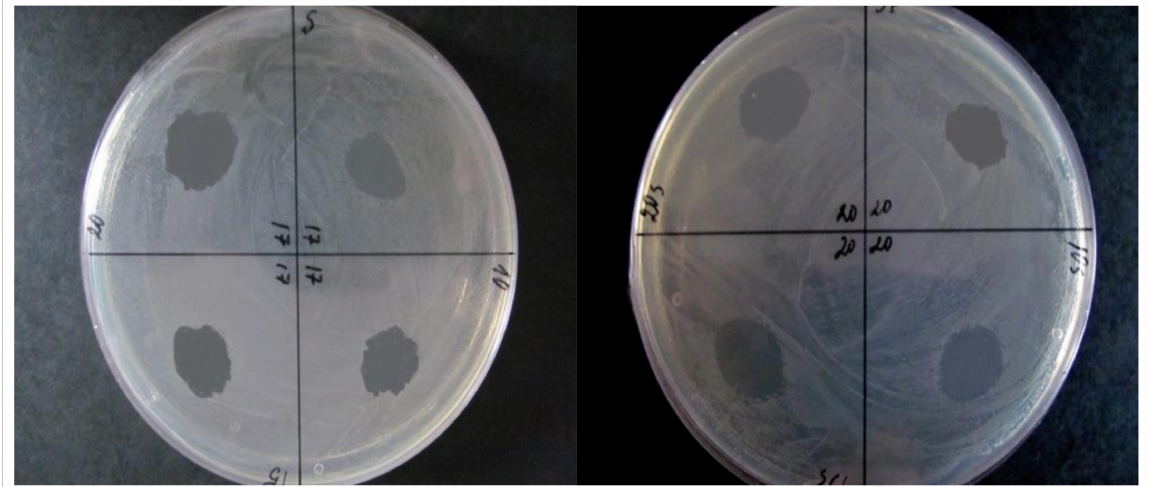
Figure 1. Photographs of sterilization zones on agar plates with 3 × 10 5 cells/cm 2 bacterial density of Pseudomonas aureofaciens AP-9 at 17 W ( left ) and 20 W ( right ) wave power. The different sectors on Petri plates were treated with different durations—top-left 5 s, bottom-left 10 s, bottom-right 15 s, top-right 20